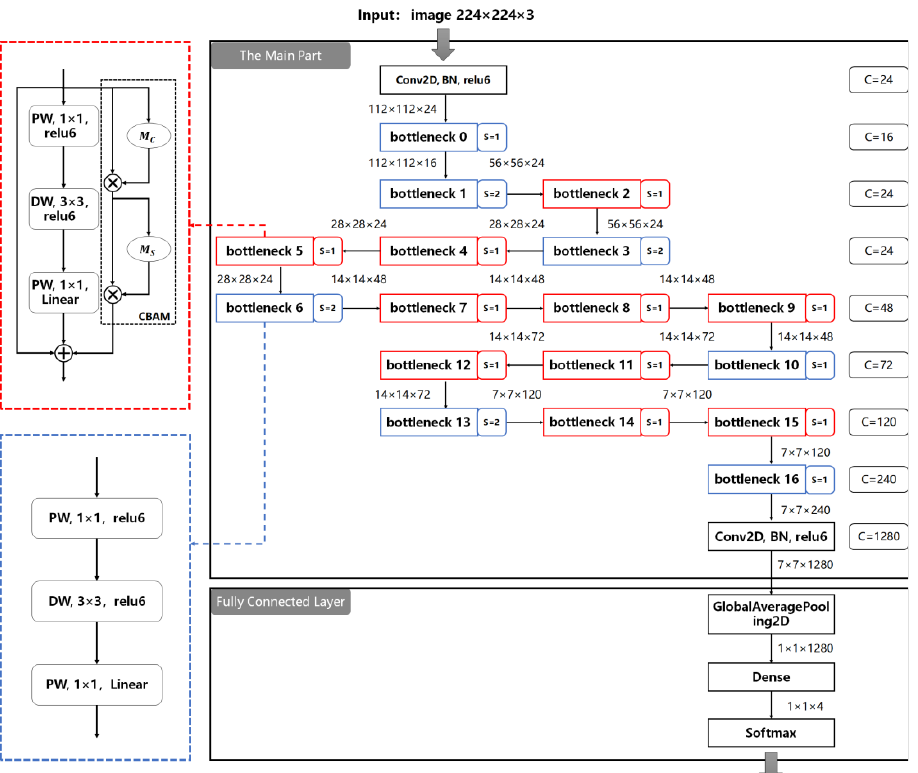
6 of 19 Table 1. Sample distribution of weld surface defect dataset. Sample Class